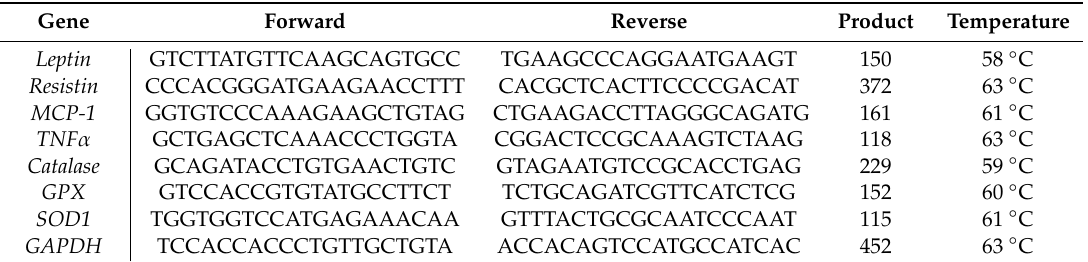
Table 1. Primers used for